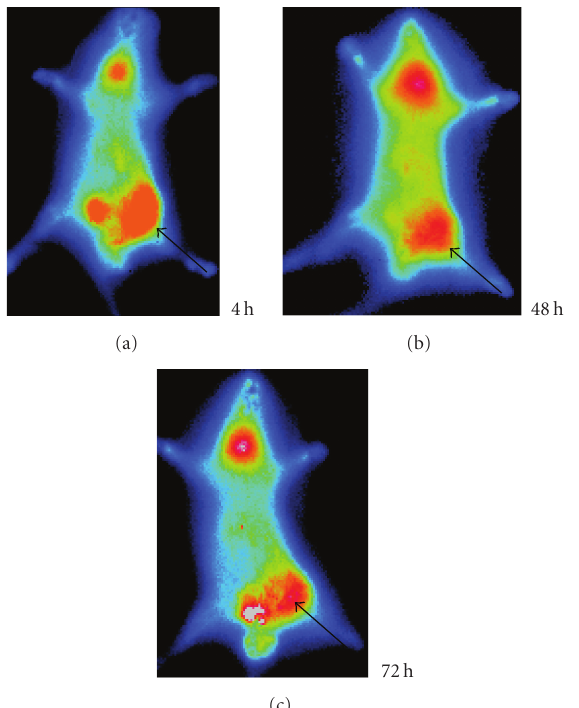
Figure 5: Serial images of turpentine group at di ff erent times: the left thigh inflammation lesion accumulated more radioactivity of 125 I-anti-MIF McAb and was visualized clearly.